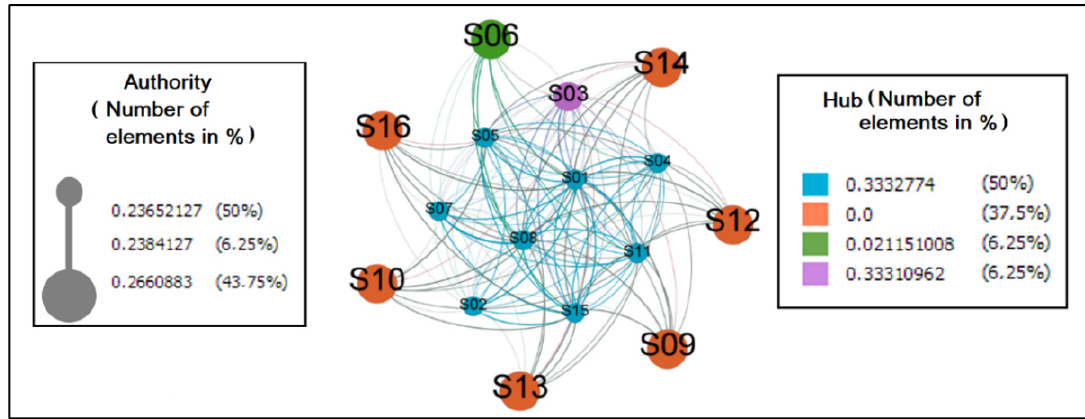
Figure 9. Messages between the HITS (authority and hub) pairs.